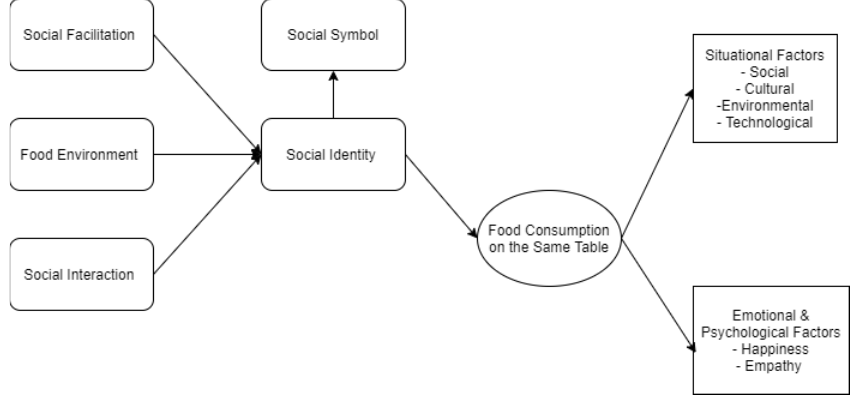
Figure 2 : Thematic Maps of Communal Food Consumption